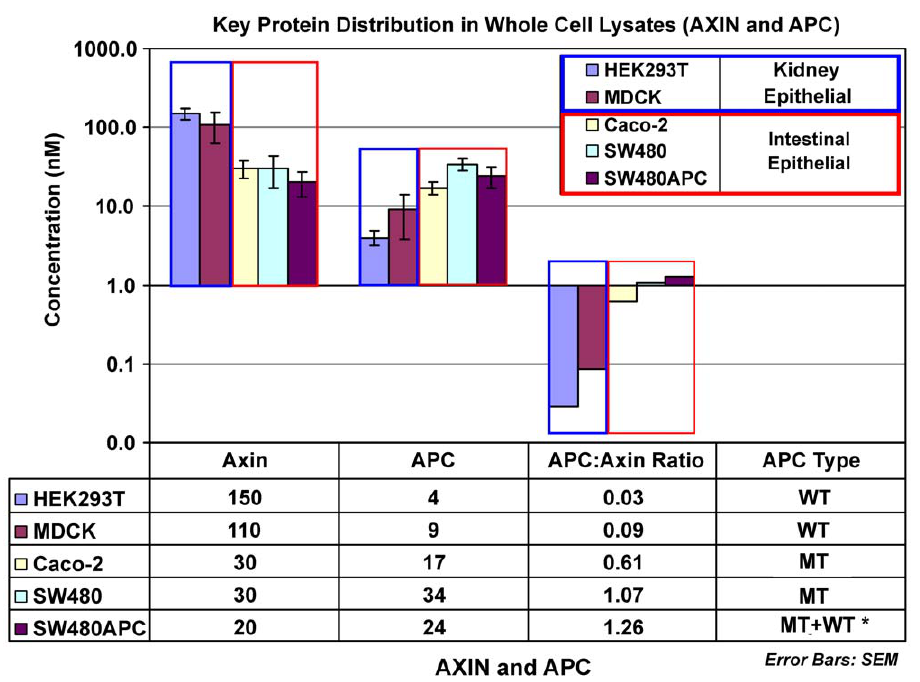
Figure 8. Concentrations of Axin and APC in mammalian whole cell lysate. The data is displayed in log scale. * Note that for SW480APC, as the level of wild-type (WT) APC is too low to be detected in this set of experiments, the measurements made in this study comprised that of mutant (MT) APC only. Error Bars: SEM.